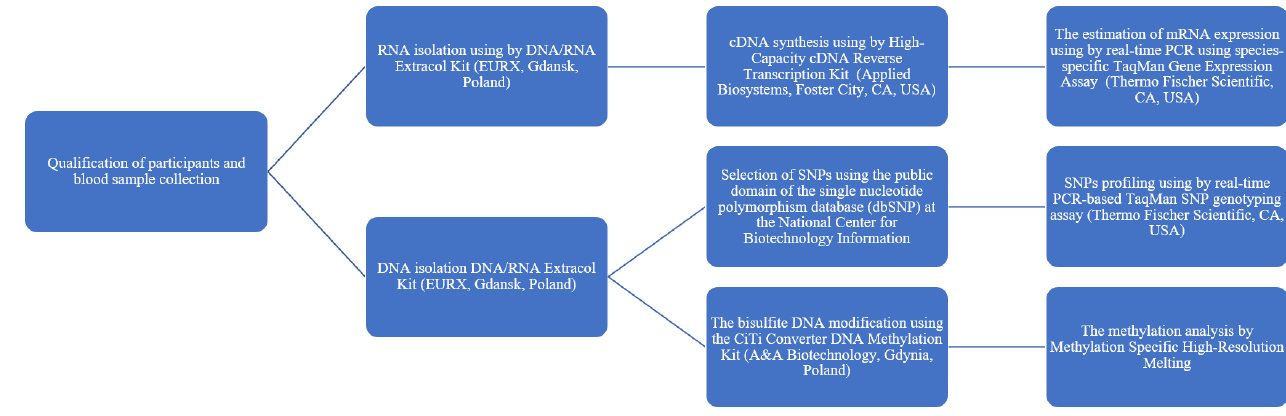
Figure 9. The course of planned experiments.